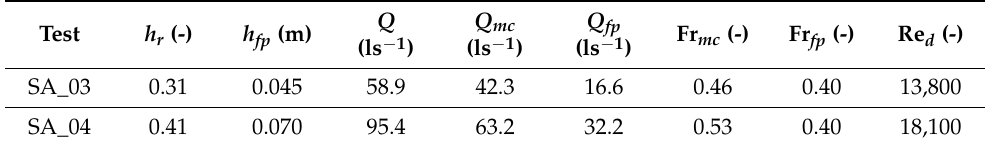
Table 1. Experimental uniform-flow parameters.